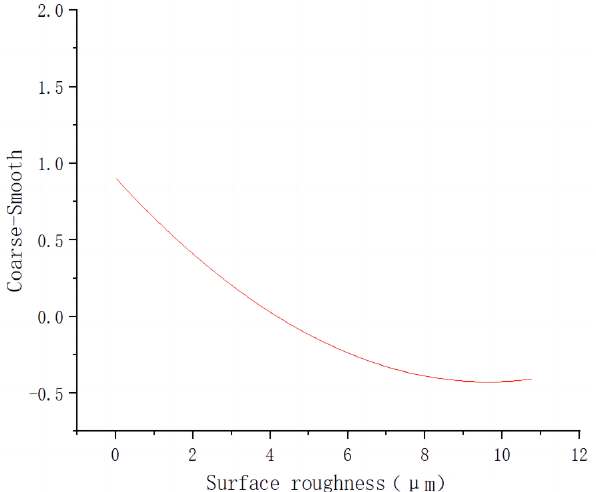
Figure 11. “Coarse-Smooth” and Surface roughness polynomial fitting function.